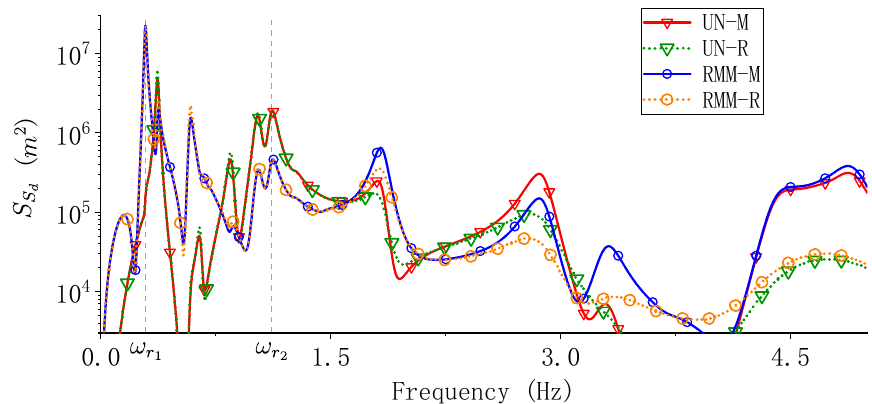
Figure 14 . Comparison of the PSD of (cid:1845) (cid:3031),(cid:2871) when different modeling methods are used Figure 14. Comparison of the PSD of S d ,3 when di ff erent modeling methods are